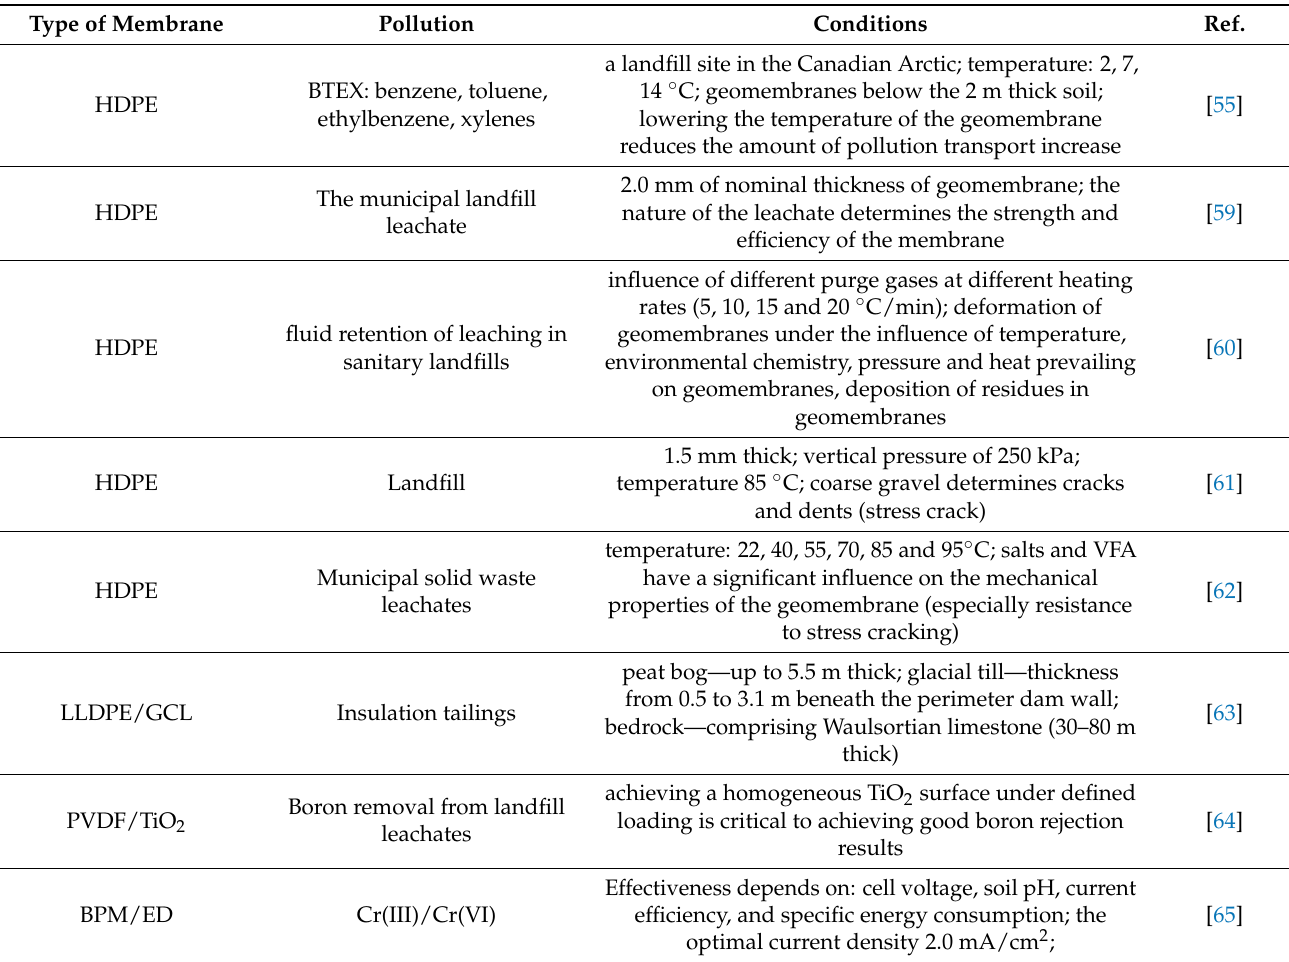
Table 2. Examples of the use of membrane techniques to soil